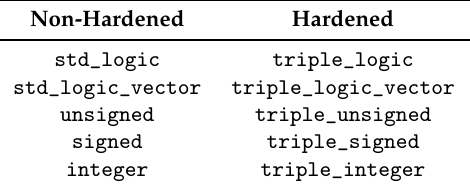
Table 1. Equivalence between non-hardened and hardened data types.